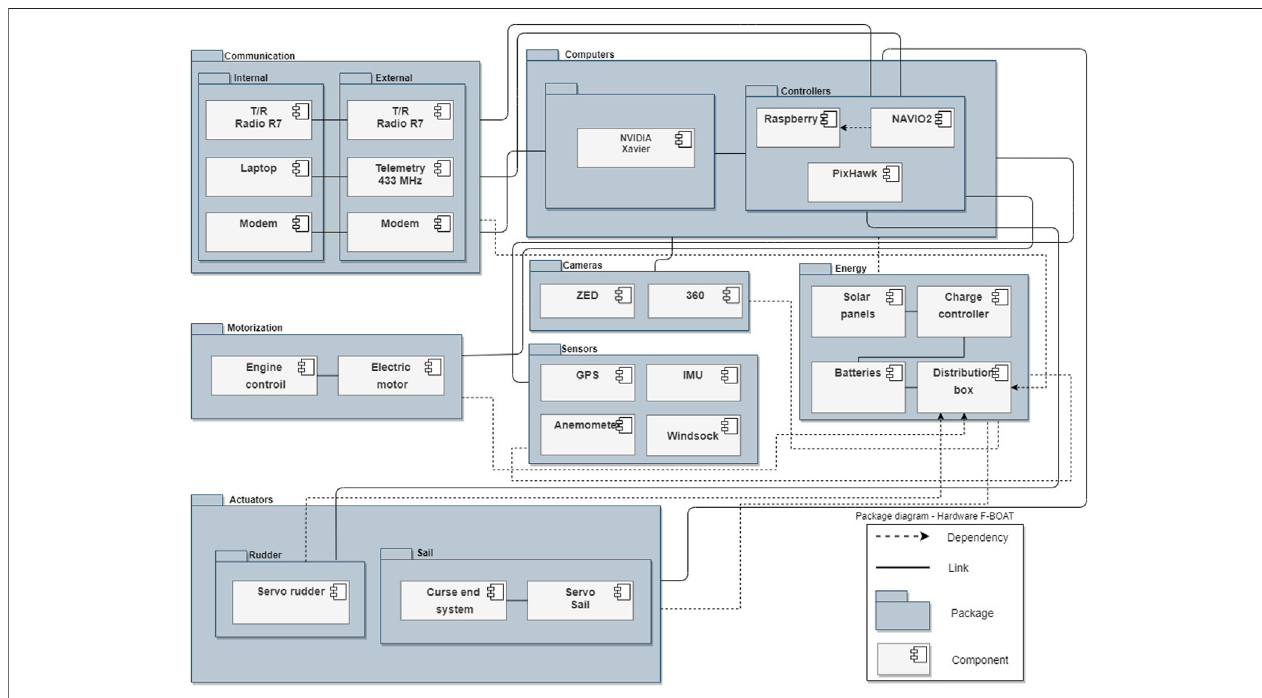
FIGURE 9 | F-Boat ’ s package fl ow